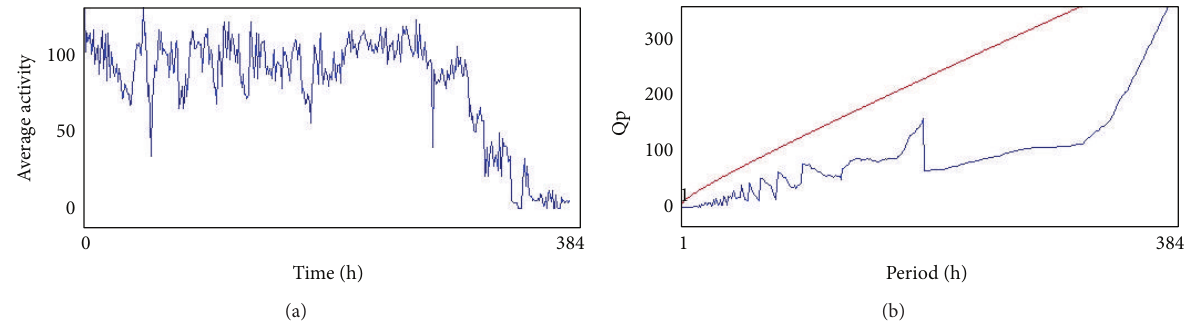
Figure 11: (a) and (b) show the average activity pattern and chi-square periodogram, respectively, for the control flies exposed to 0.25 𝜇 L/mL of Centella asiatica leaf extract in diet ( 𝑁 = 20 ).